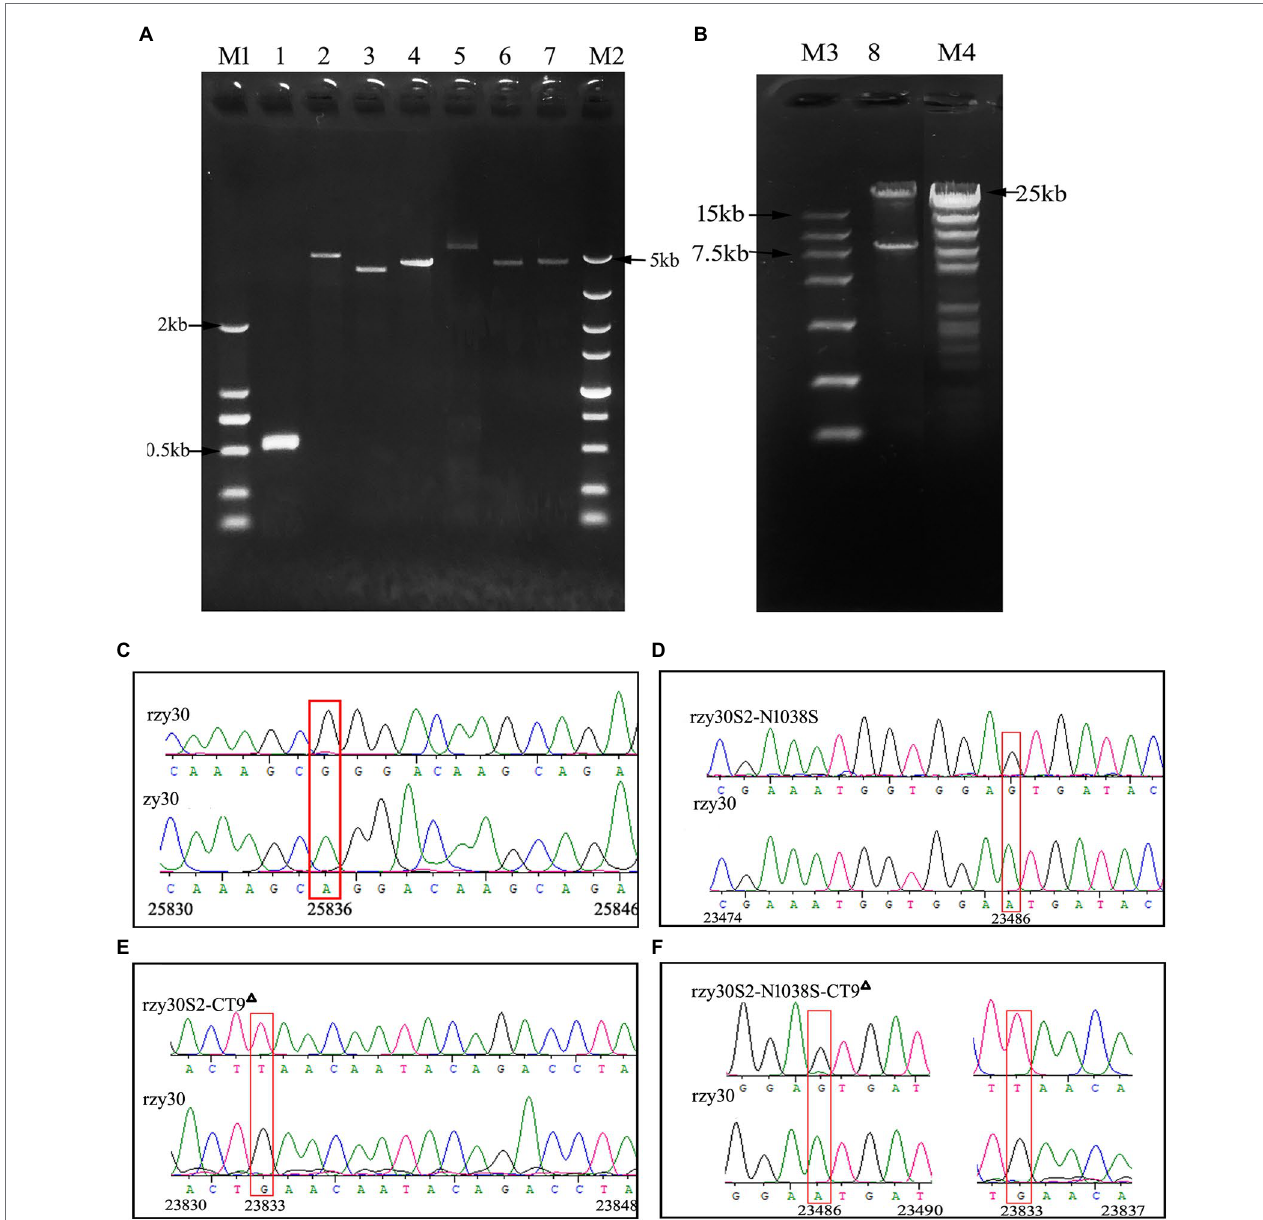
FIGURE 3 | The recovered rzy30 based on BAC plasmid were confirmed. (A) Lane 1 to Lane 7 represent purified PCR fragments (IBV-1, IBV-2, IBV-3, IBV-4, IBV- 5, IBV-6, and IBV-7) of zy30 genome used for the clone. Lane M1 and M2 represent the 2 kb and 5 kb DNA ladder, respectively. (B) Plasmid BAC-zy30 (Lane 8) was cleaved into two segments of approximately 28 kb and 7.6 kb in length by BamHI restriction enzyme digestion. Lane M3 and M4 represent the 15 kb and 23 kb DNA ladder, respectively. (C) The silent substitution (A to G) was introduced at 25,386 nt to distinguish rzy30 from zy30 as shown in the red box. (D) The mutation at 23,486 nt (A to G) was identified in rzy30S2-N1038S. (E) The mutation at 23,833 nt (G to T) was identified in rzy30S2-CT9 △ . (F) The mutations at 23,486 nt (A to G) and 23,833 nt (G to T) were identified in rzy30S2-N1038S-CT9 △